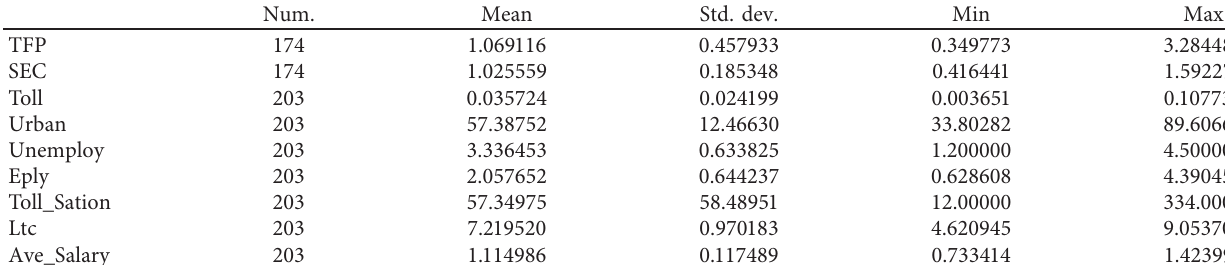
Figure 1: Average operating efficiency in China. Table 3: Descriptive statistics of the main variables.